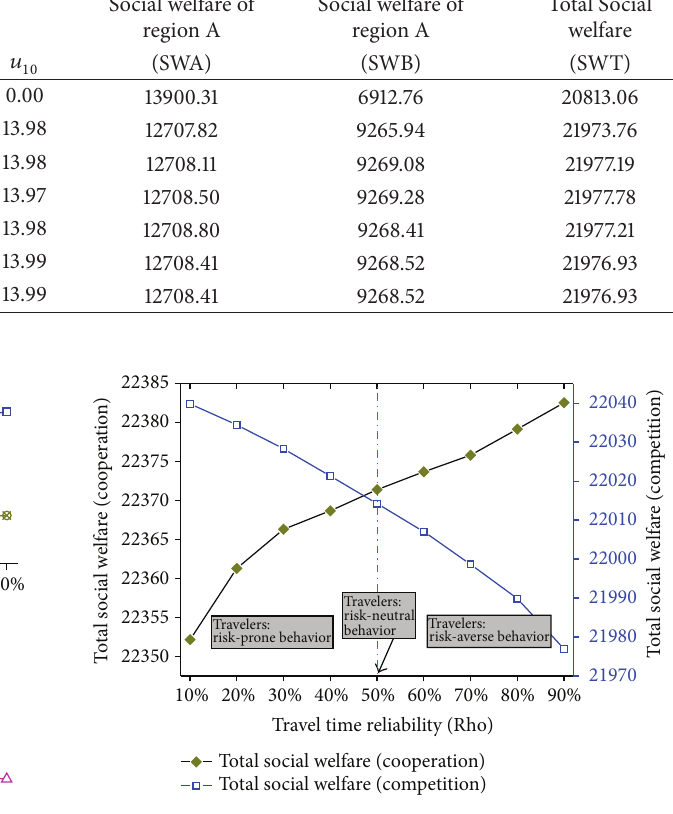
Figure 4: Total social welfare with different travel time